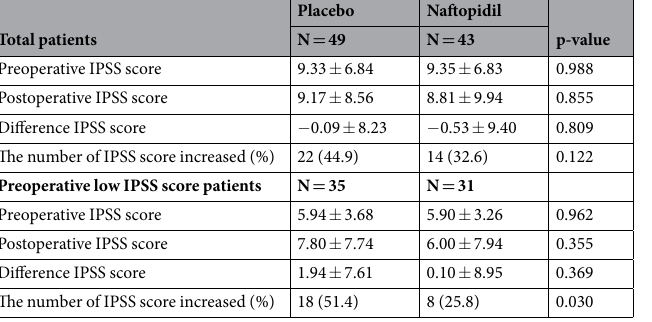
Table 5. Subgroup analysis according to international prostate symptom score. IPSS, international prostate symptom